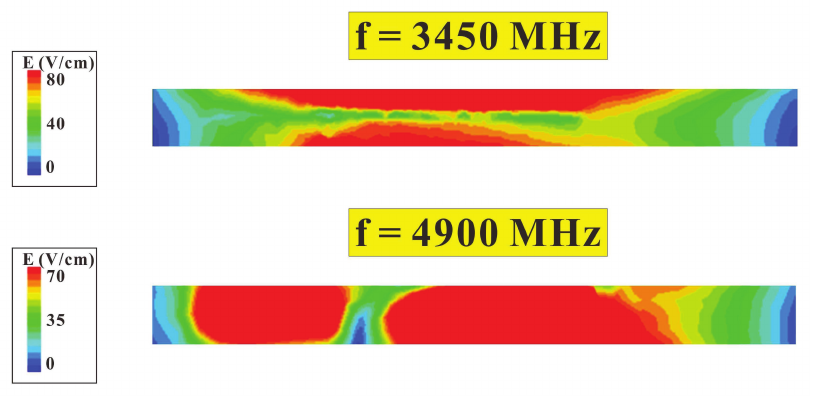
Figure 11. Electronic field simulation and distribution for single antennas at 3450 MHz and 4900